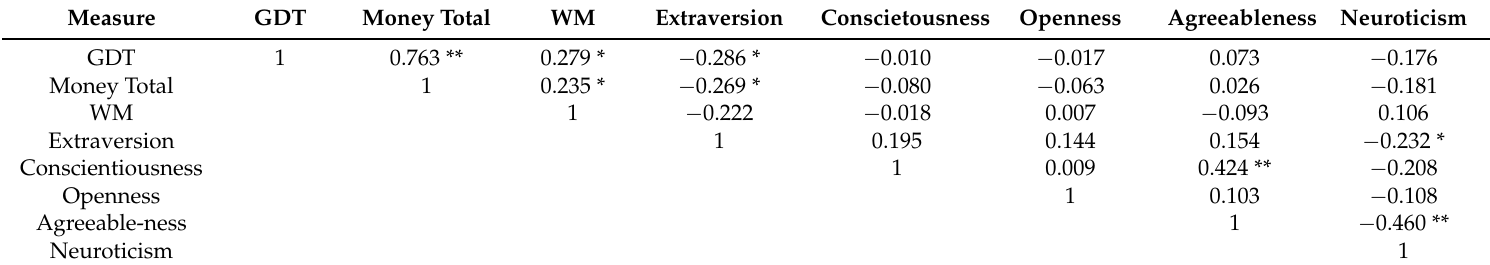
Table 4. Correlations between GDT, money total, working memory, and personality in young